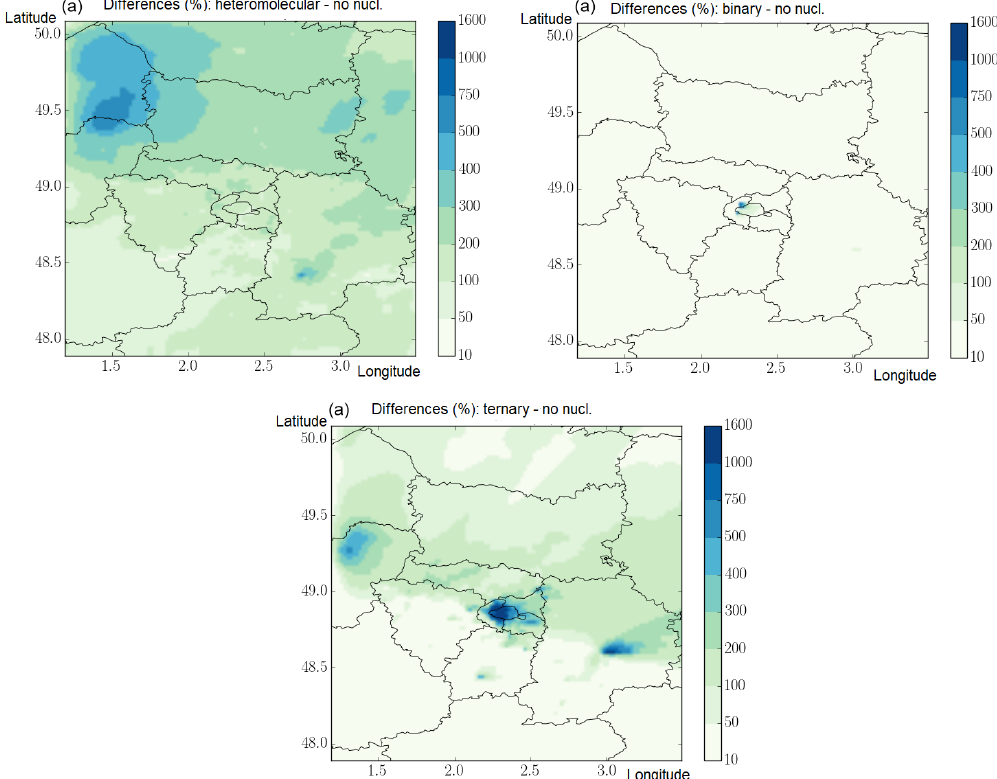
Figure 5. Differences in number concentrations (in %) between simulations with and without nucleation. The nucleation parameterisations used are the heteromolecular (a) , the binary (b) , and the ternary (c)